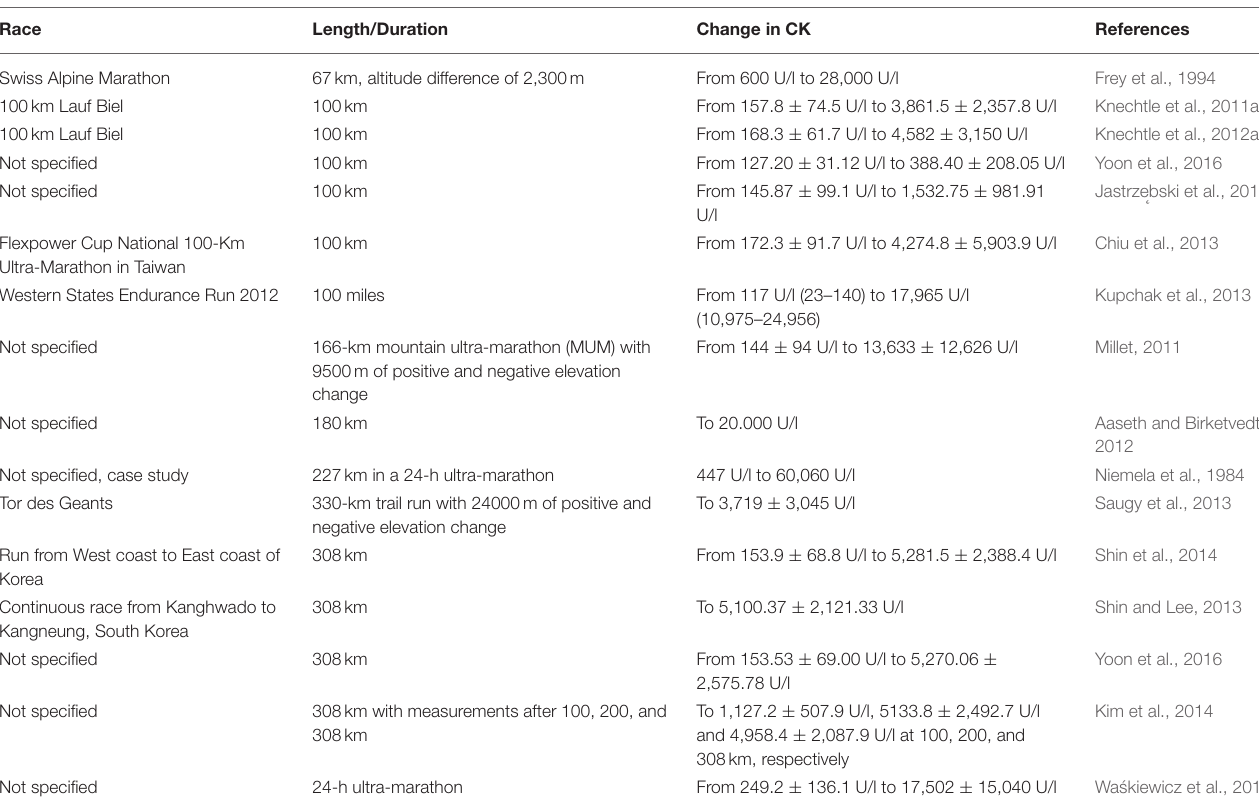
TABLE 10 | Pre- and post-race CK-values from different races, sorted by the length of the races.